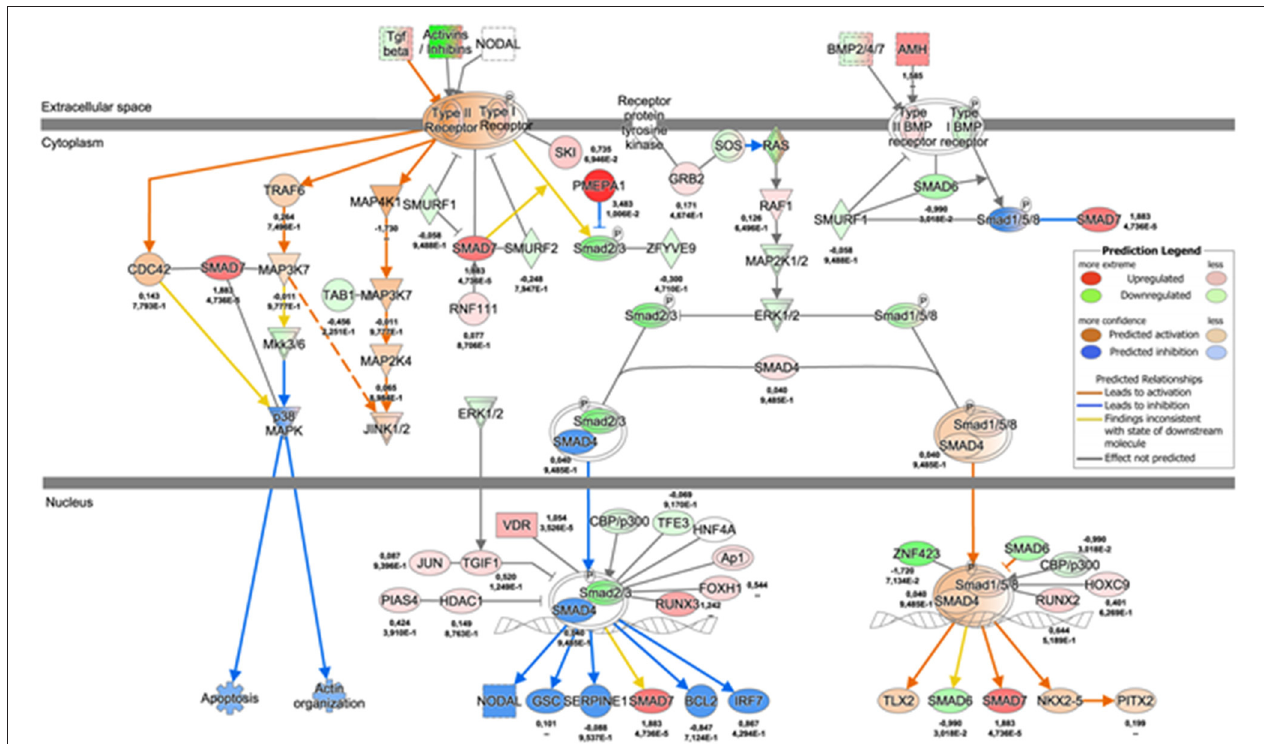
FIGURE 5 | TGF- β signaling pathway map 72h dyn vs. 72h stat condition. Network depicting the regulation of TGF- β signaling cascade at 72h, as represented by IPA. The values underneath each protein (when expressed in the dataset) indicate respectively the logFC and the adjusted p -value from the DE analysis between 72h dyn and 72h